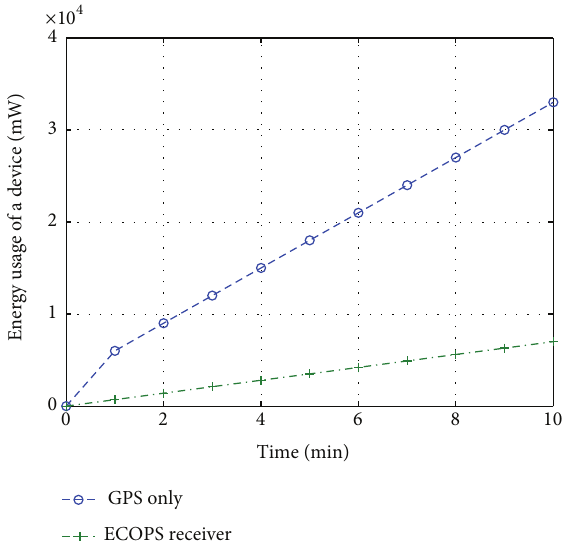
Figure 12: Comparison of individual node energy consumption: GPS versus ECOPS